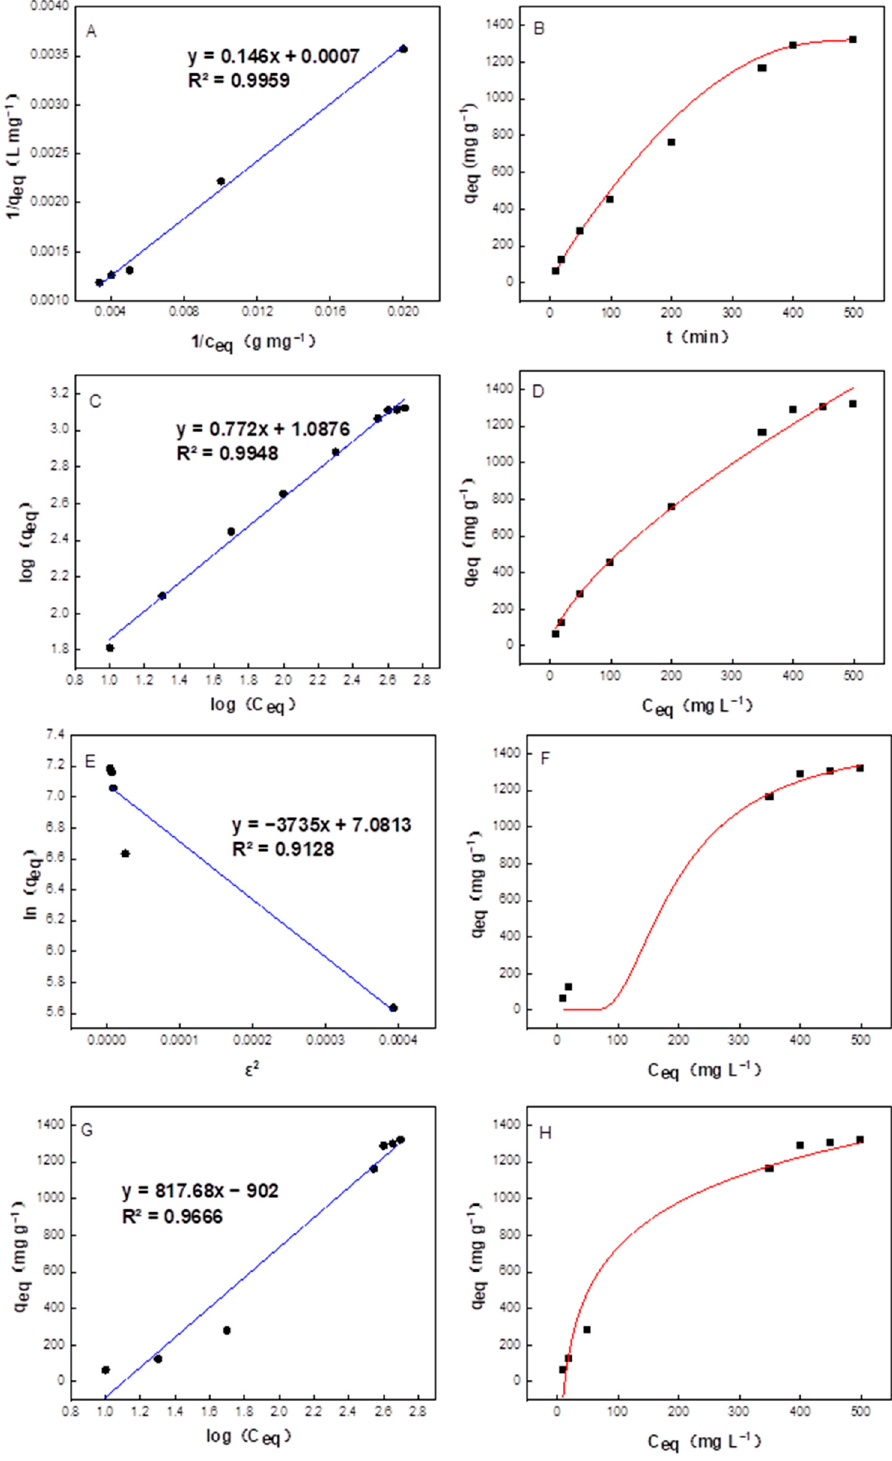
Figure 5. Linear and nonlinear plots of Langmuir isotherm model ( A , B ), Freundlich isotherm model ( C , D ), Dubinin–Radushkevich isotherm model ( E , F ), and Temkin isotherm model ( G , H ) of PrK adsorption by Co 4 PW–PDDVAC composite.